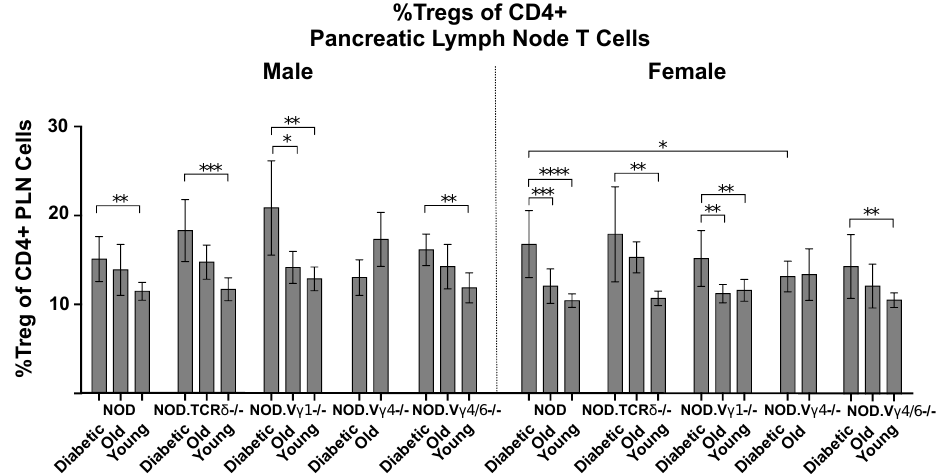
Figure 6. The mean percentage of Tregs present among CD4+ αβ T cells in the pancreatic lymph nodes of NOD-background γδ T cell subset-deficient vs. wt NOD mice. Results from mice with recent-onset diabetes were compared to both young and older sex-matched mice, within and between strains. For each group, samples from 3–16 mice were analyzed by flow cytometry, except for two groups, diabetic male NOD.V γ 1-/- mice and diabetic male NOD.TCR δ -/- mice, in which diabetes generally developed very rarely and only 2 mice were available (errors bars for these 2 groups show the range obtained rather than the sample standard deviation). * p < 0.05, ** p < 0.01, *** p < 0.001, and **** p <